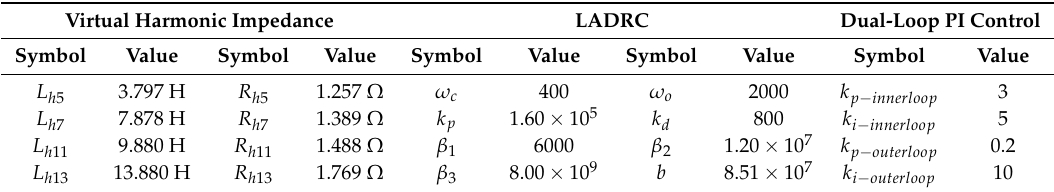
Table 5. Controller Parameters in Experiments.